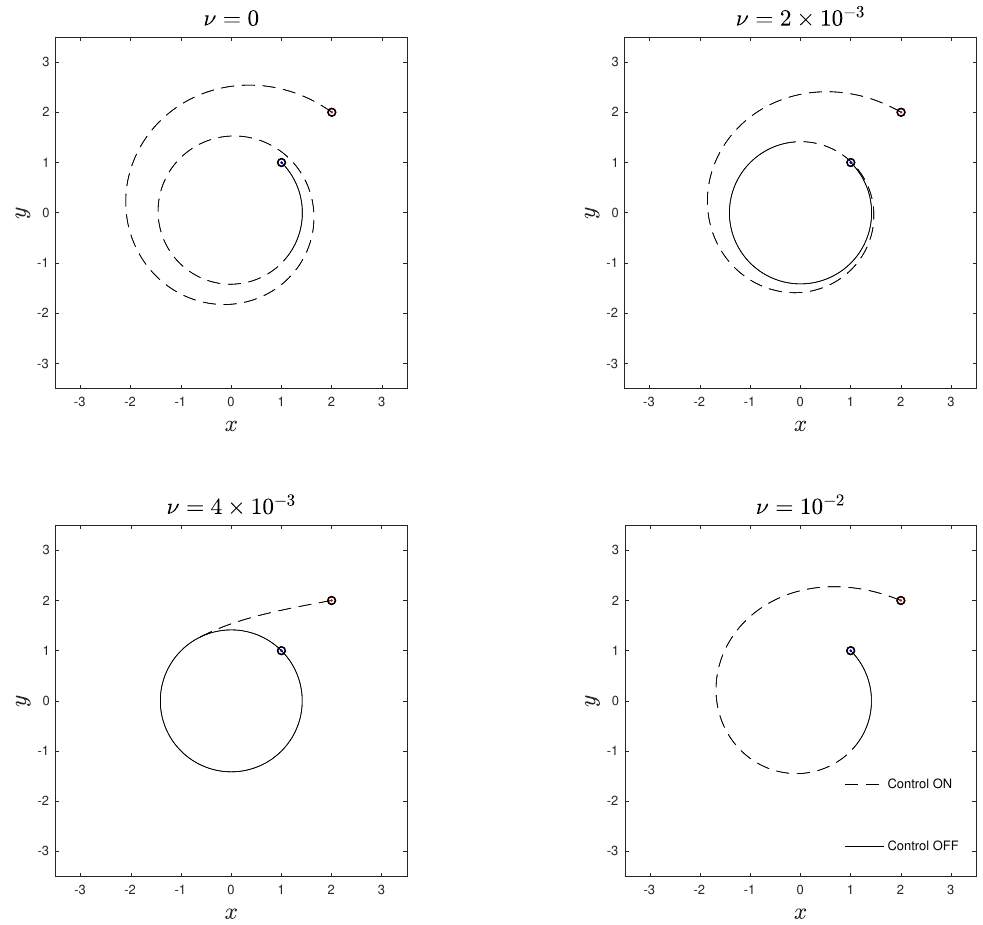
Figure 5. Optimal trajectories for the particle in the problem with parameters ρ 0 = 2 √ ρ T = 2 m, θ 0 = θ T = π /4, k = 1 m 2 s − 1 and different kinematic viscosities for the flow. The dashed lines correspond to the part of the trajectory where the control is active, and the solid lines indicate the part of the trajectory where the control is off. For comparison, the scenario ν = 0 m 2 s − 1 is shown, and the trajectory is drawn with the parameters obtained analytically from the expressions given by Marques et al.